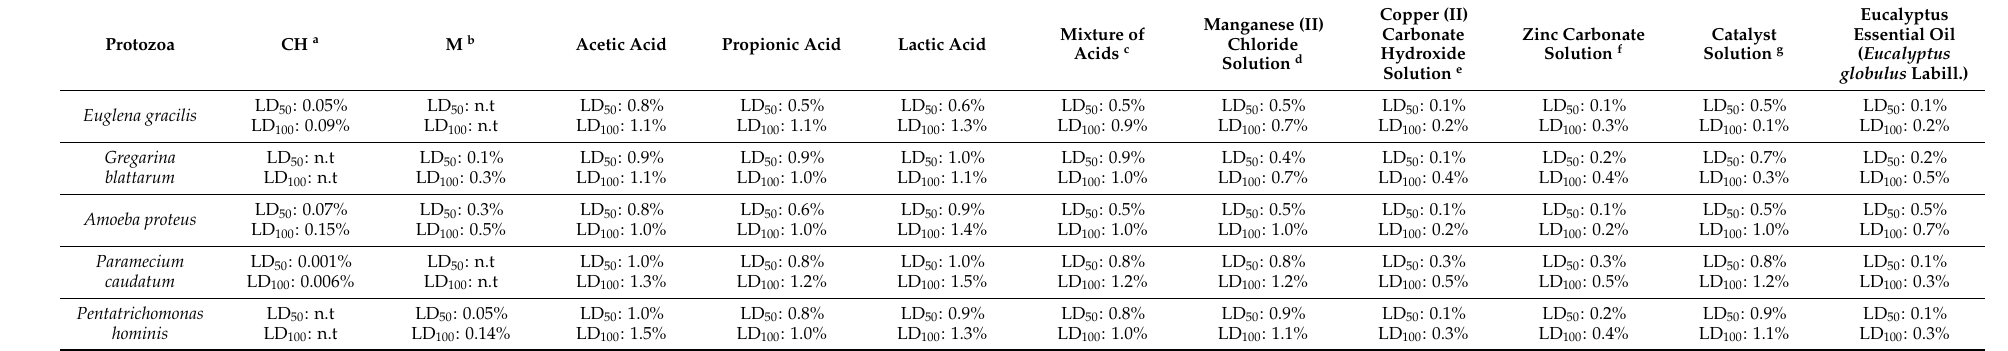
Table 2. LD 50 , LD 100 values of eucalyptus essential oil ( Eucalyptus globulus Labill .) and the components used in the study.